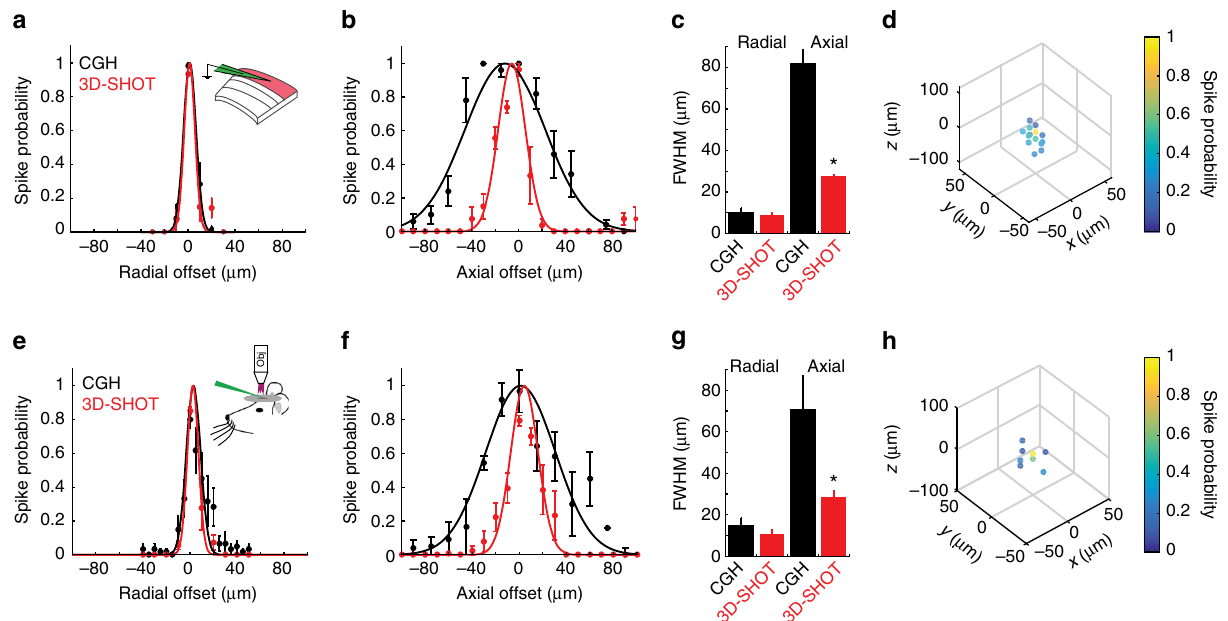
Fig. 4 3D-SHOT provides high spatial resolution photo-activation of neurons in vitro and in vivo. a Spatial pro fi le of two-photon evoked spiking of a L2/3 pyramidal neuron in a mouse brain slice in the radial dimension. (CGH: black, n = 12 neurons; 3D-SHOT: red, n = 14 neurons; p = 0.56 Mann − Whitney U -test. Data represent mean ± s.e.m). b As in a ) but along the axial dimension (CGH n = 11 neurons, 3D-SHOT n = 5 neurons, p = 0.006). c Quanti fi cation of the FWHM comparing CGH and 3D-SHOT (data represent mean and s.e.m.). d Full volumetric assessment of photostimulation resolution using 3D- SHOT. Points throughout the volume were tested, but only points that elicited spike probability greater than zero are shown (data represent mean of n = 7 neurons). e − g As in a − c but for neurons recorded via in vivo 2P guided patch: radial: p = 0.46; axial: p = 0.004, CGH ( n = 6 neurons), and 3D-SHOT ( n =